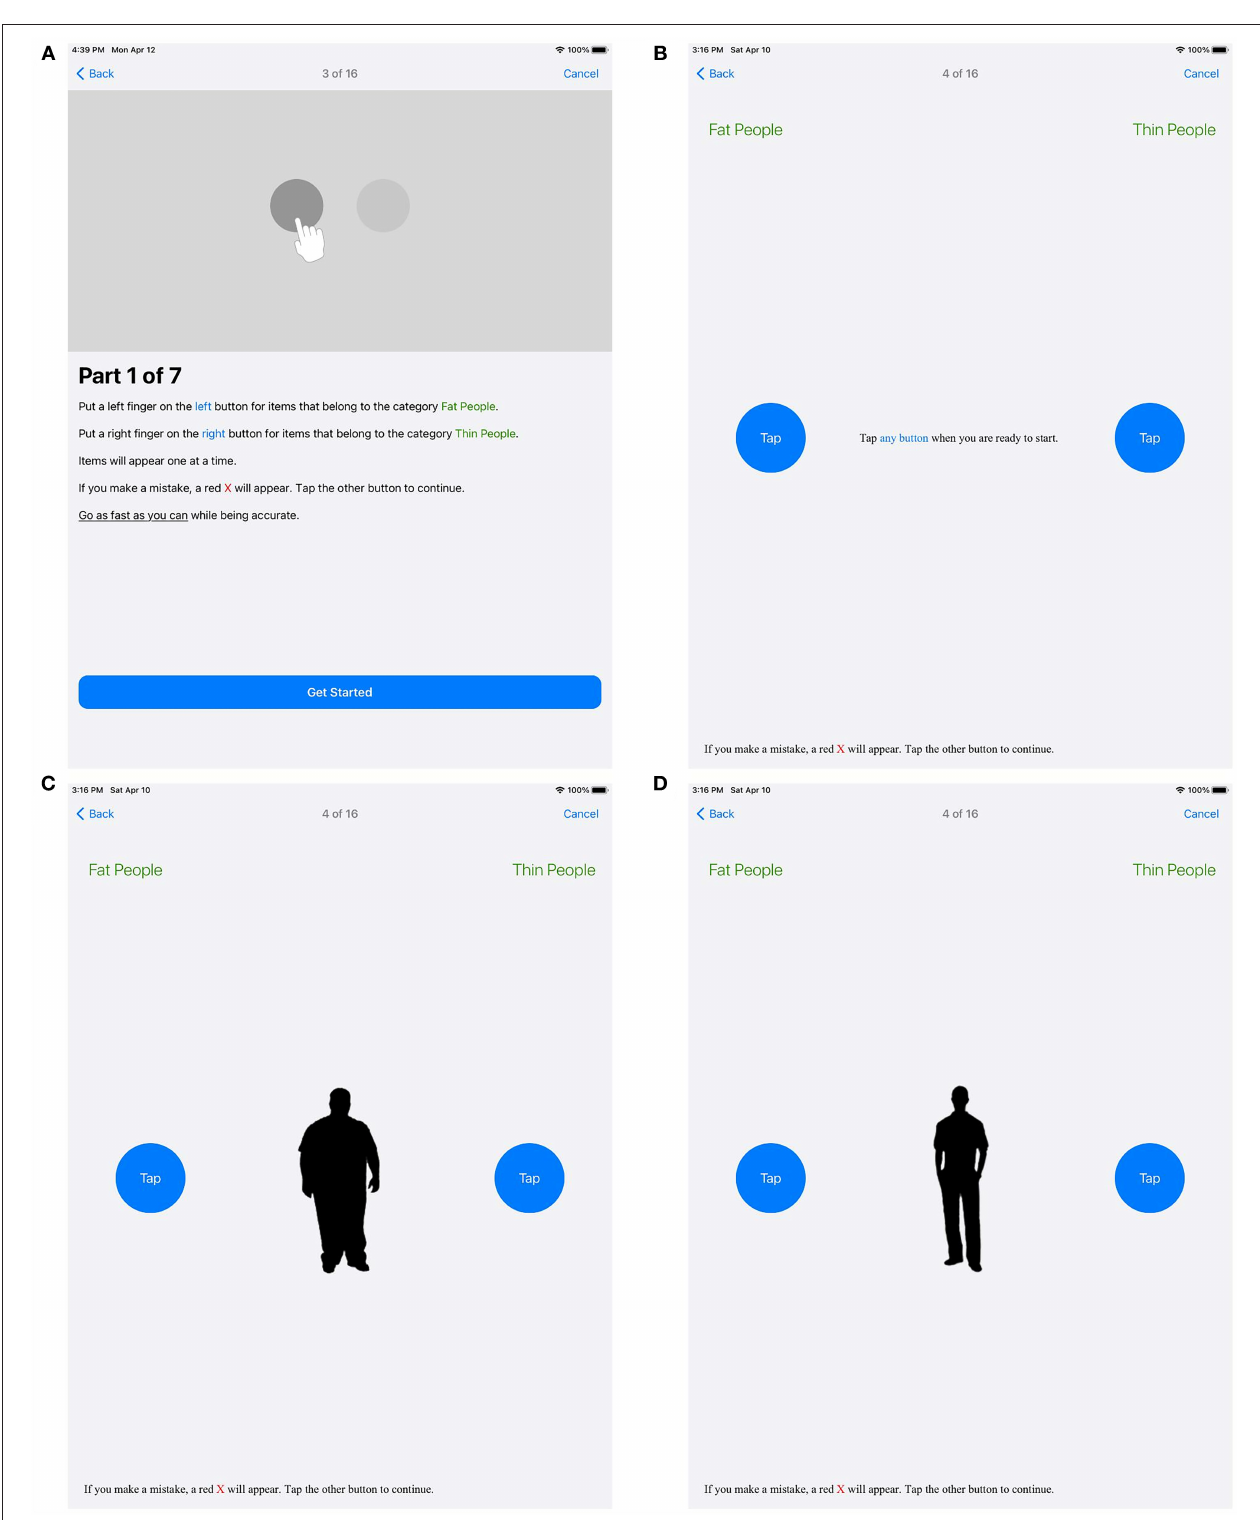
FIGURE 4 | Block 1. Explanations on how to perform the test (A) and an information screen (B) are displayed before the first test block. During the test, the stimuli are shown in random order (C,D) .